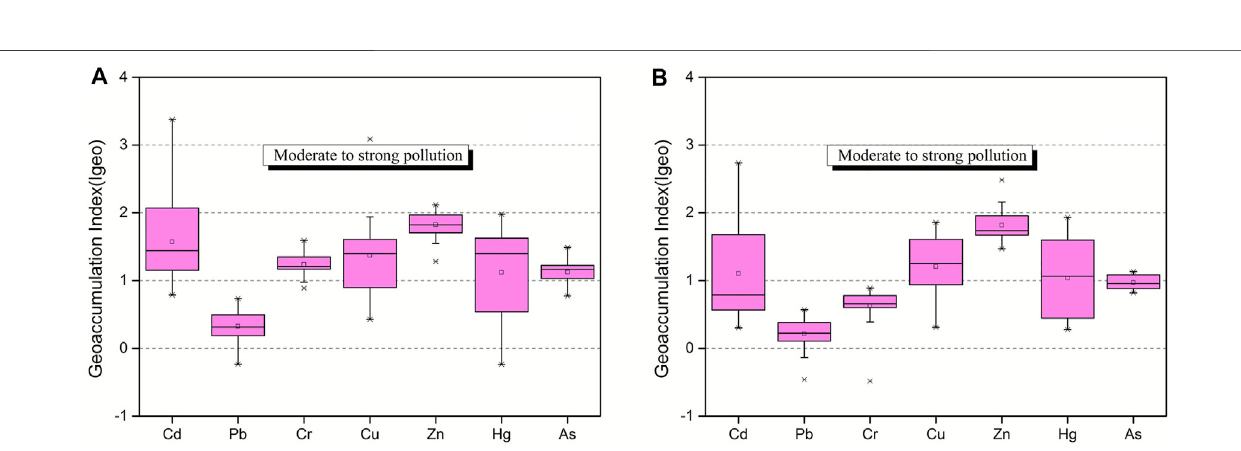
Frontiers in Environmental Science |